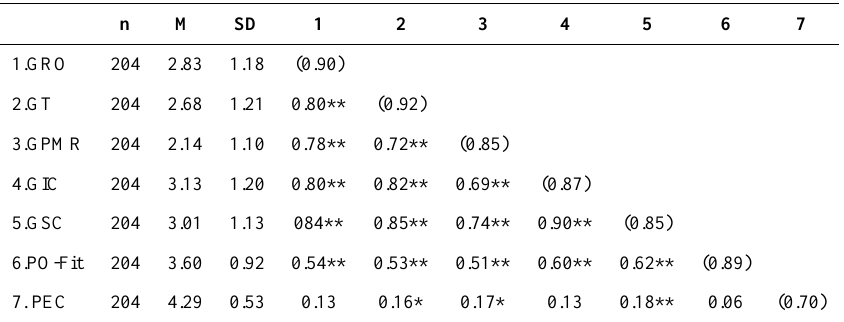
Table 2. Means, standard deviations, and correlations among